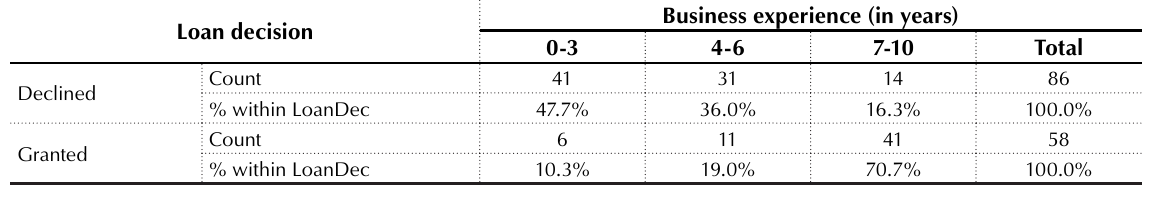
Table 5. Collateral